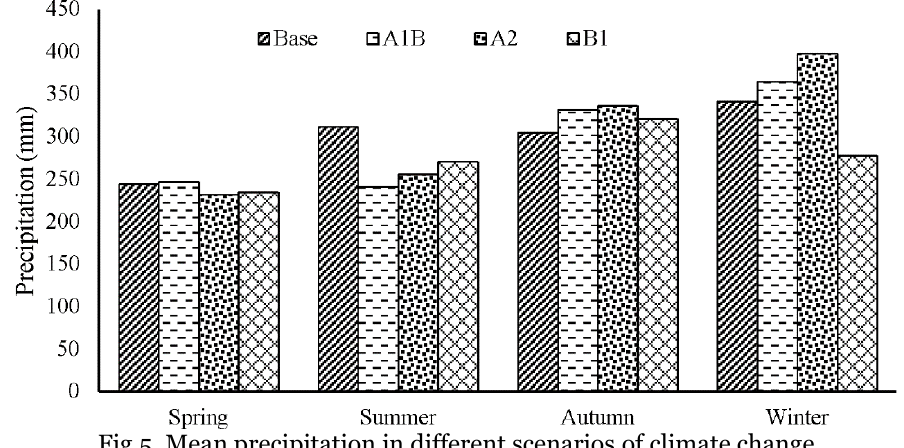
Fig.6 showed runoff curve number map in average moisture